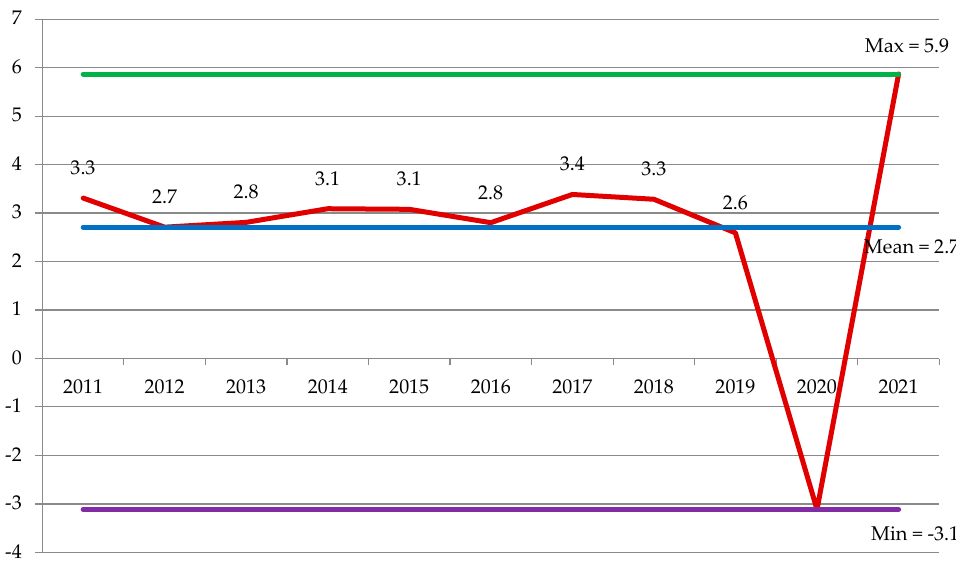
Figure 7. The world value added growth rates (%) by key sectors of the global economy in 2011– 2021.